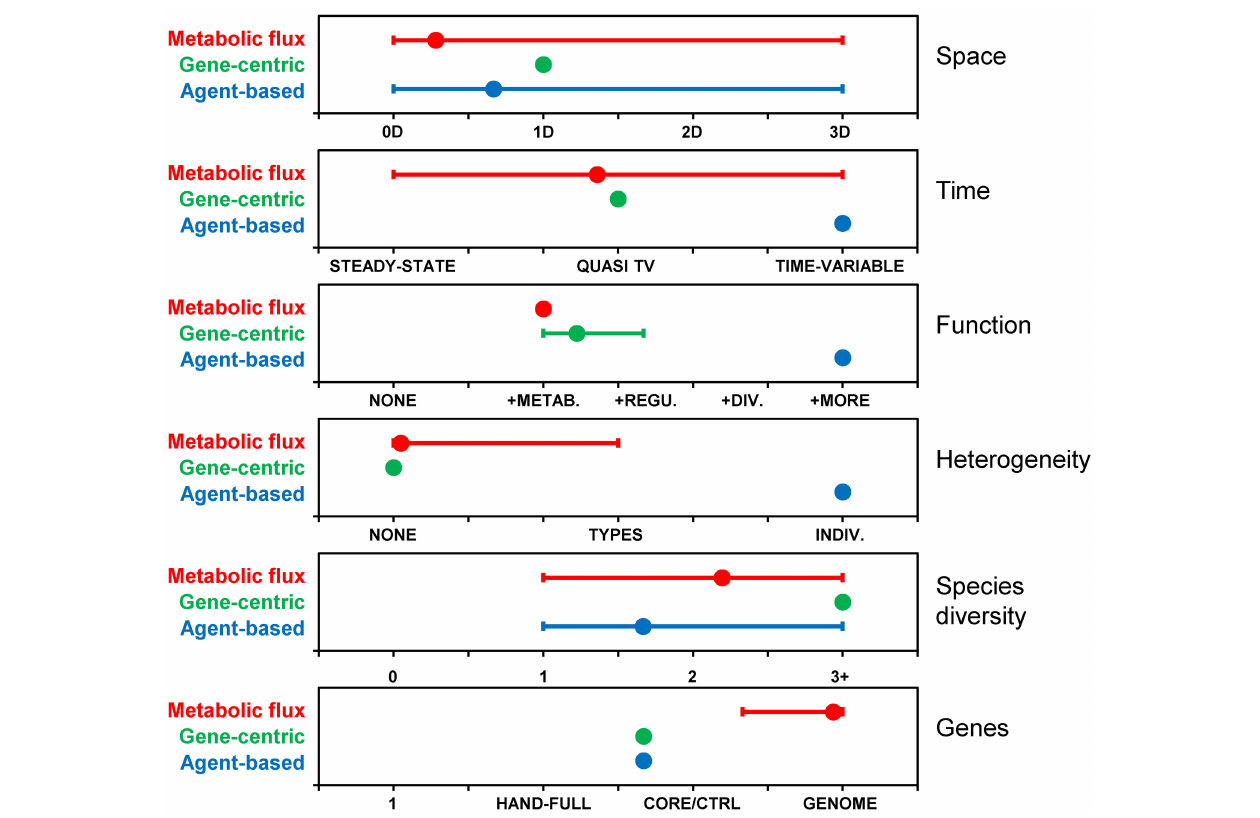
FIGURE 5 | Comparison of modeling approaches along various dimensions. Based on metabolic flux ( N = 32), gene-centric ( N = 3) and agent-based ( N = 6) models included in this review. Dimensions: Space: 0 (i.e., well-mixed reactor), 1, 2 or 3 dimensional; Time: steady-state, quasi-time-variable (e.g., dynamic FBA), time-variable; Function: None, metabolism, + regulation, + division, + additional functions; Heterogeneity (individuality): None, types (i.e., phenotypes), individuals; Species diversity: None, one, two, three or more; Genes: None, a handful, core/central metabolism, whole genome. Symbols represent averages and “error bars” the range between minimum (i.e., dimensions covered by all models) and maximum. For example, agent-based models have been developed with zero to three spatial dimensions, and the average is